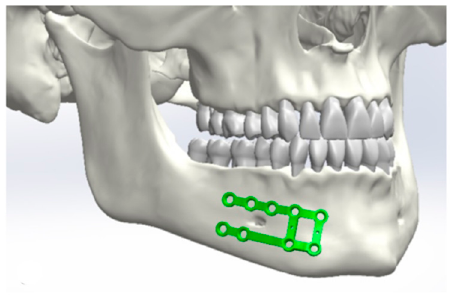
Figure 2. Positioning of the osteosynthesis plates in the area of the body.